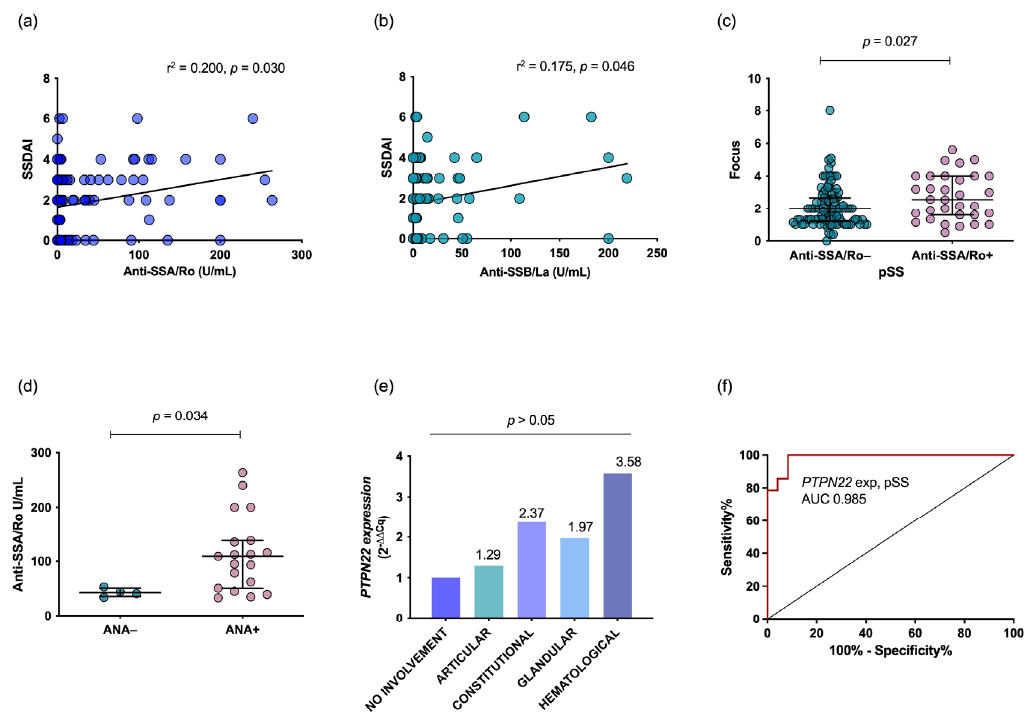
Figure 2. Association and correlation of autoantibodies, clinical activity and PTPN22 expression. The SSDAI score showed a positive correlation with anti-SSA/Ro and anti-SSB/La autoantibodies ( a , b ). The inflammatory focus of the MSG was associated with anti-SSA/Ro+ pSS ( c ). pSS patients positive for ANA had higher anti-SSA/Ro levels ( d ). High hematological, glandular, constitutional and articular domain scores were associated with greater PTPN22 mRNA expression ( e ). PTPN22 gene expression was accurate for pSS diagnosis ( f ). Spearman’s rank correlation test was used. Qualitative gene expression data are shown through the 2 − ∆∆ Cq method; the p value was obtained by the Mann–Whitney U test using quantitative gene expression data from the 2 − ∆ Cq method. AUC was calculated through ROC analysis. Data are shown as the median and IQR. AUC: area under the curve, ANA: antinuclear antibodies, MSG: minor salivary gland, pSS: primary Sjögren´s syndrome, IQR: interquartile range, ROC: receiver operating characteristic.